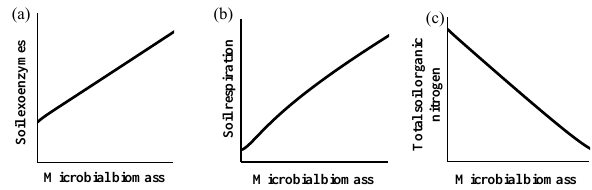
Figure 6. General trends predicted by the ForPRAN model of (a) soil exoenzymes, (b) soil respiration, and (c) total soil organic N as a function of microbial biomass under conditions of increasing availability of C and